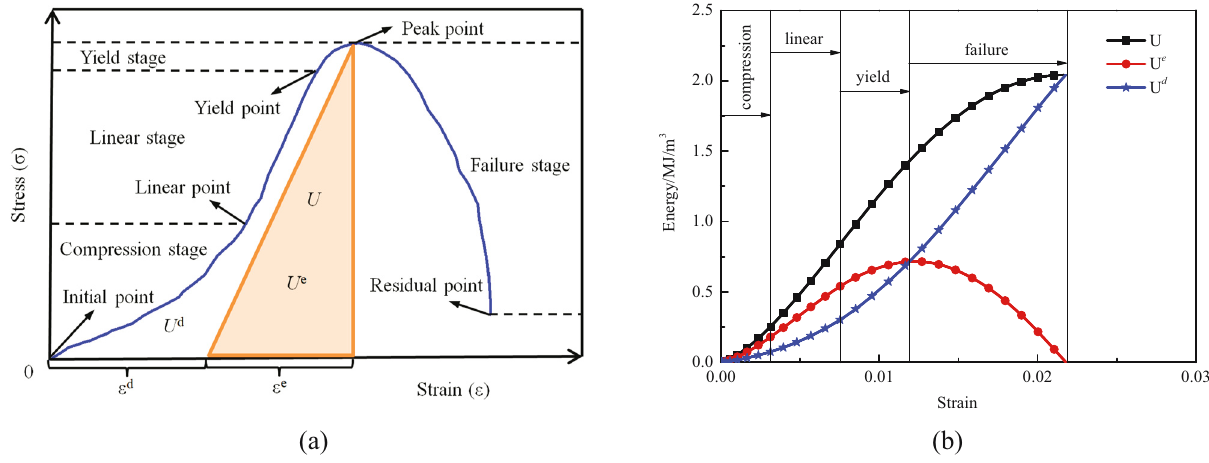
Figure 4: Dynamic energy curves of sandstone specimens after H – C cycles: ( a ) diagram of the staged stress – strain curves; ( b ) energy evolution curve of sandstone ( room temperature )